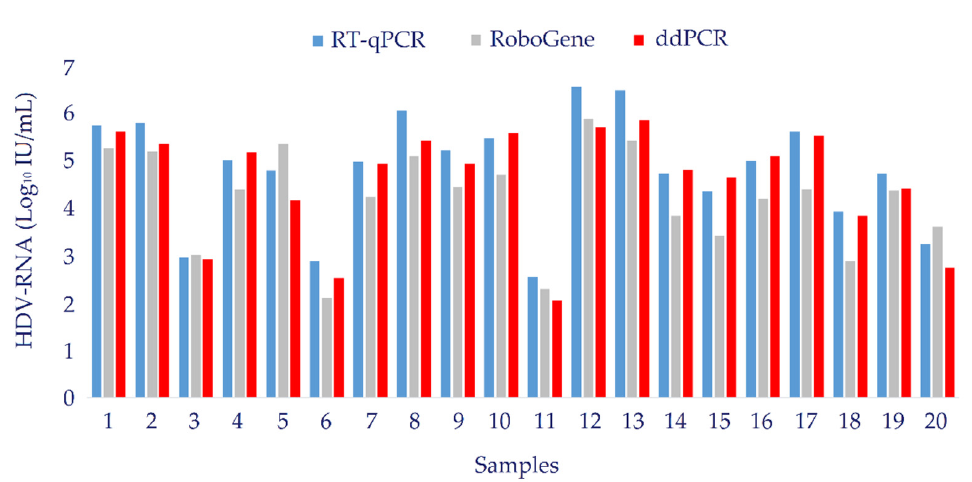
Figure 9. Histogram showing the comparison of HDV-RNA values obtained by RT-qPCR, ddPCR and RoboGene HDV RNA Quantification Kit 2.0. Blue bars represent values obtained by RT-qPCR. Data obtained by ddPCR and RoboGene HDV RNA assay are represented by red and gray bars, respectively.